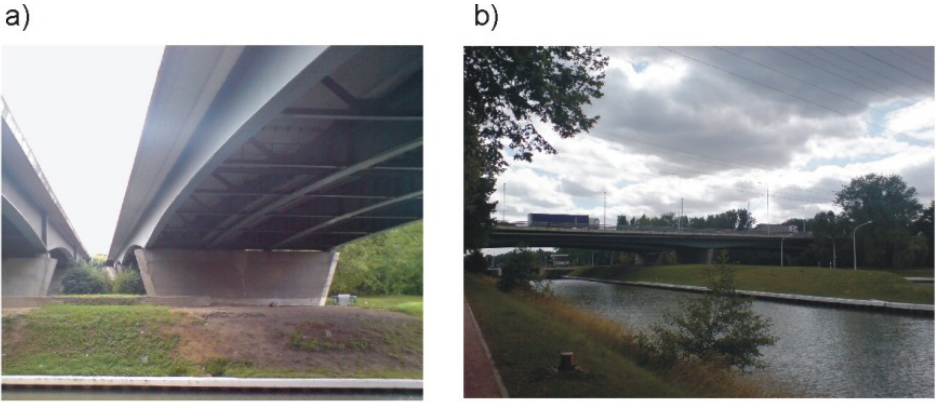
Figure 35: Pictures of the A15 motorway bridge over River Oise in 2008: good structural condition (slab condition of the second bridge on the left – built more recently without tendons – is not so